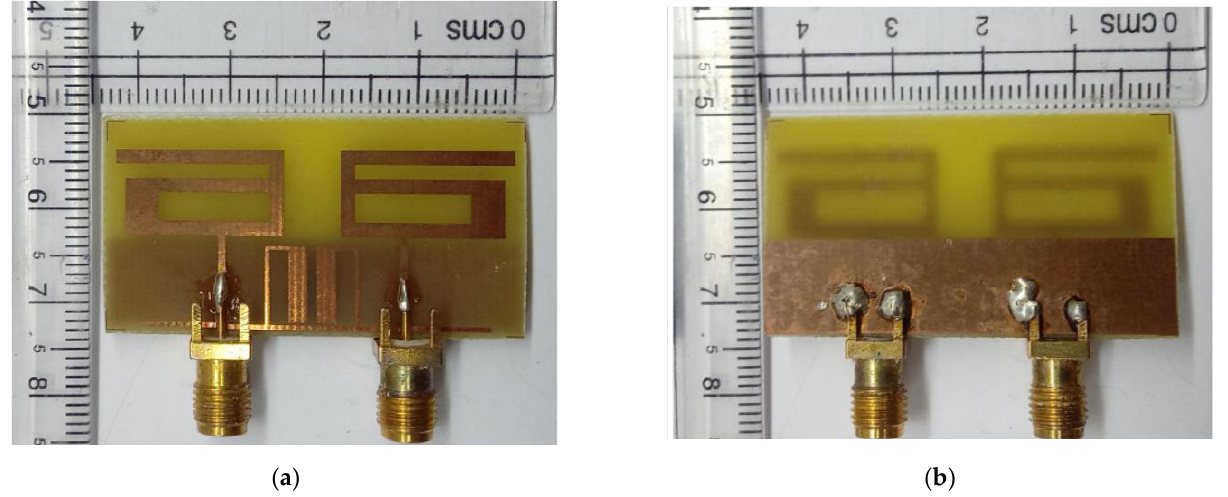
Figure 14. Prototype model of proposed two-port MIMO antenna: ( a ) front view; ( b ) back view.